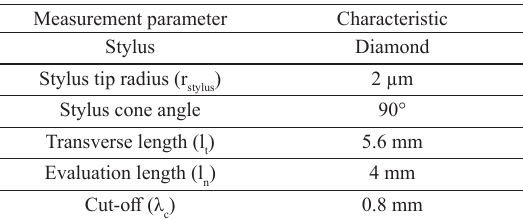
Table 2 – Setup for surface roughness measurements of sawn mono-Si